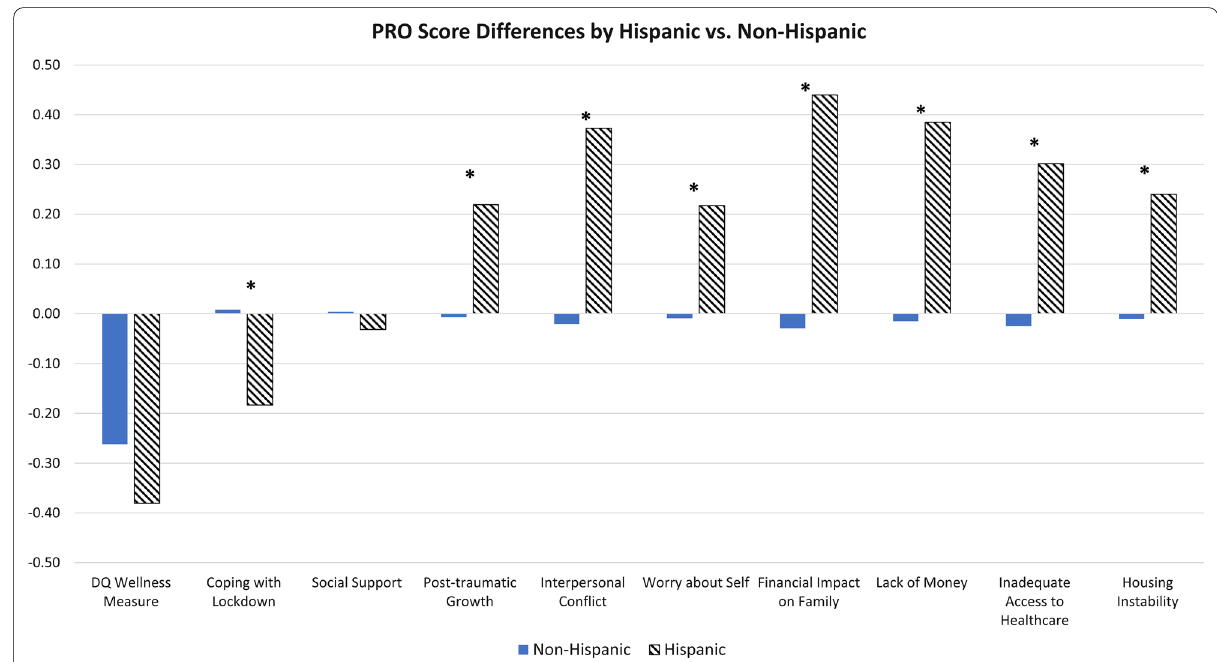
Fig. 3 PRO Score Differences by Hispanic vesus Non-Hispanic. Statistically significant differences are indicated by an asterisk above the